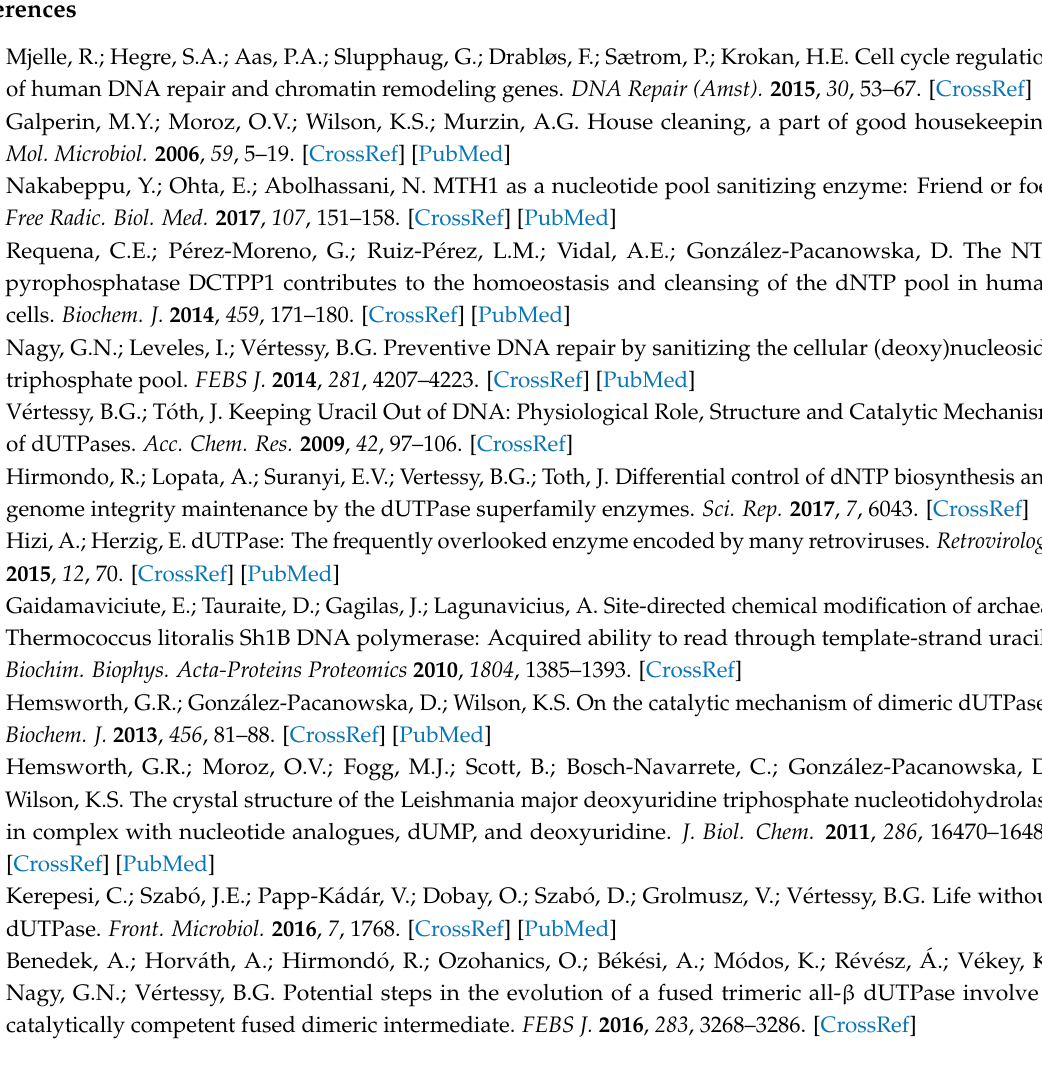
Figure S1: Sequencing analysis of dut gene from founder mouse #2 and #4, Figure S2: Alignment of the sequencing results from wild-type and mouse #4 animals, Figure S3: Phase contrast images of embryos obtained by crossing D47 heterozygous mice, Figure S4: Outgrowth assay of preimplantation embryos obtained by intercrossing D47 heterozygous mice, Figure S5: Images of embryos at 8.5 dpc obtained by crossing D47 heterozygous mice, Figure S6: Images of embryos at 9.5 dpc obtained by crossing D47 heterozygous mice, Figure S7: Full-length agarose gel of Figure 2b, Figure S8: Full-length membrane of Figure 5a, Table S1: Oligonucleotides used in this